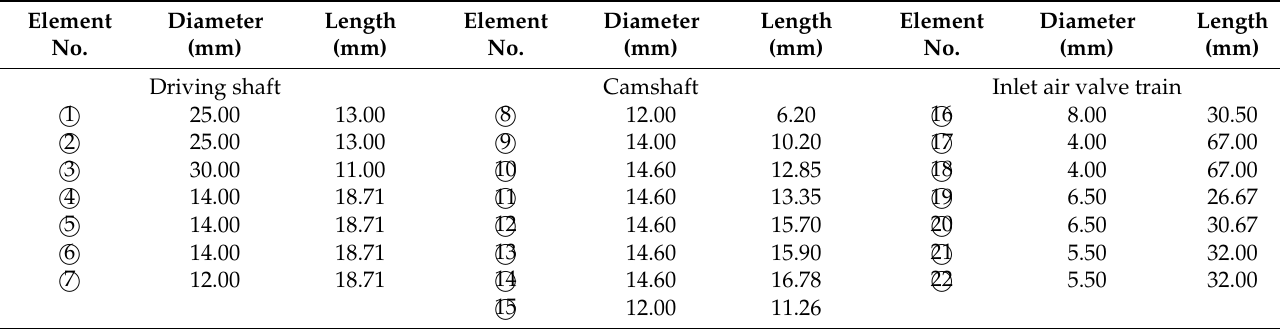
Table 1. Structural parameters of the shaft